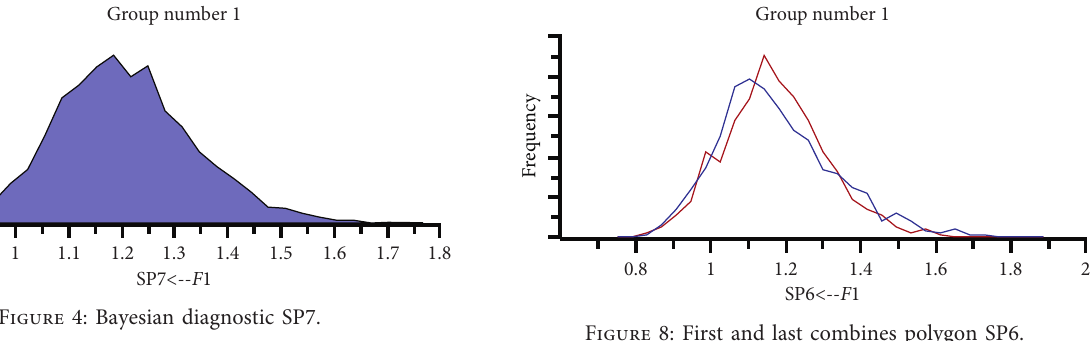
Figure 8: First and last combines polygon SP6.